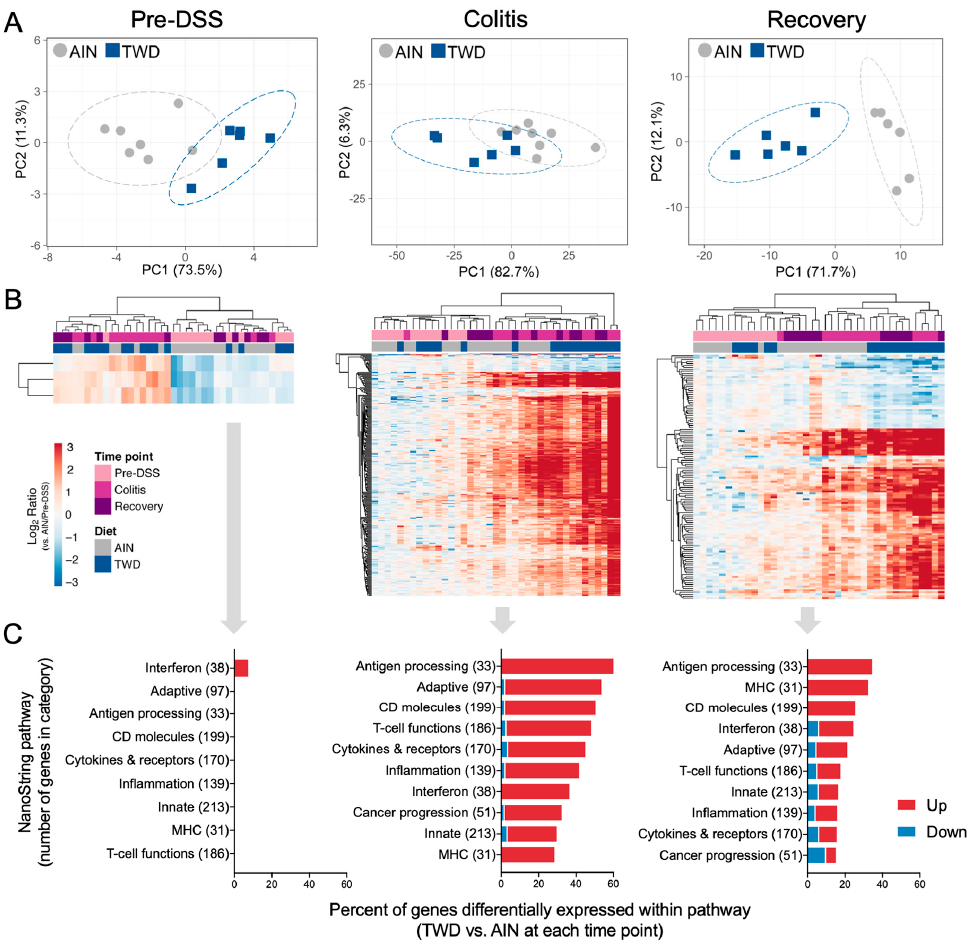
Figure 7. Exposure to the TWD prior to, during and after DSS-induced gut injury intensified changes in expression of genes associated with immune and cancer pathways as compared to mice fed AIN (Experiment E). ( A ) Principal components analyses (PCA) of di ff erentially expressed genes (BH q < 0.05, log 2 ratio > 1 or < − 1) in colon tissues of mice fed either AIN or TWD prior to DSS (Pre-DSS), during active colitis (Colitis), or two weeks later during recovery (Recovery). PC1 and PC2 are shown with the 95% prediction ellipse. Because only three genes met all significance criteria at the Pre-DSS time point, all genes di ff erently expressed by at least two-fold with an FDR p < 0.10 were used for the PCA analysis for that time point only. ( B ) Unsupervised, bidirectional hierarchical cluster analysis of colon transcriptome data using the Euclidean distance method with average linkage. For each time point, the heatmap shows all genes di ff erentially expressed between TWD and AIN diet groups colored by the log 2 ratio calculated with respect to AIN / Pre-DSS. ( C ) Bar charts indicate the number of genes di ff erentially expressed at each time point for selected immune and cancer pathways. The total number of genes a ffi liated with each pathway for the PanCancer Immune panel are indicated in parentheses.